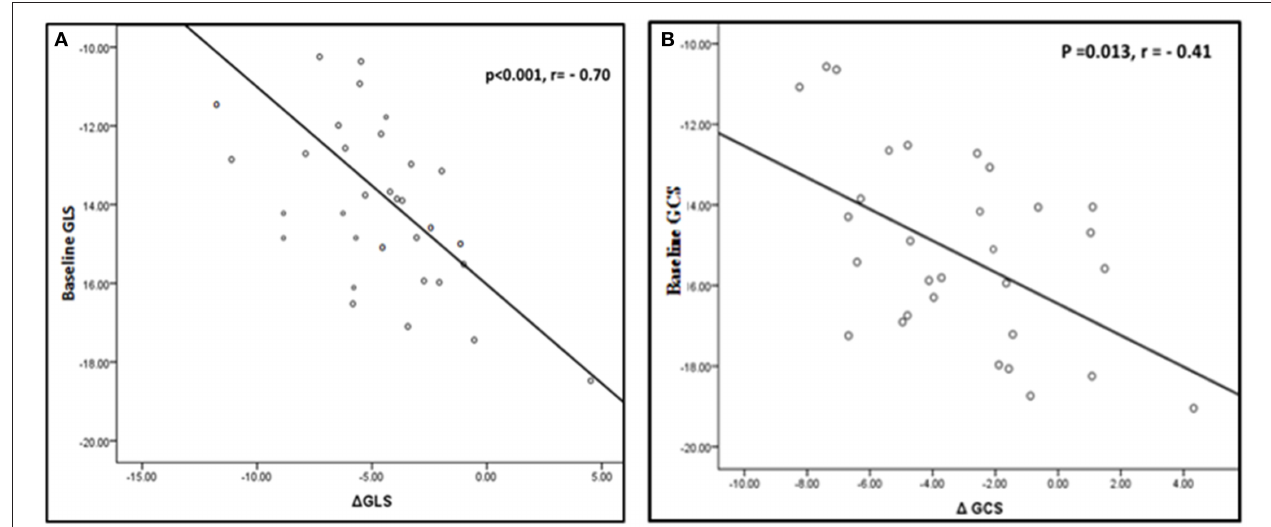
FIGURE 6 | Correlation between change in LV deformation parameters and baseline values. (A) Correlation between change in GLS and baseline GLS. (B) Correlation between change in GCS and baseline